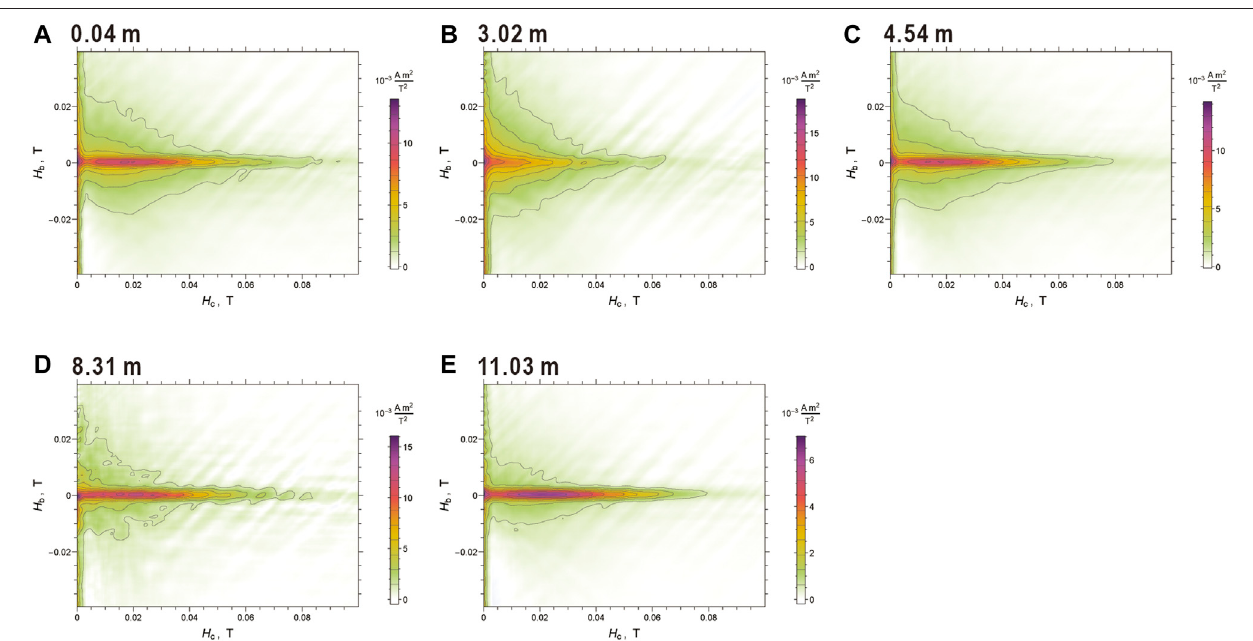
FIGURE 3 | First-order reversal curve (FORC) diagrams of fi ve samples (A – E) selected from lithologically distinct layers of core SO264-19 – 2 (dashed lines in Figure 2 top). The FORC diagrams in particular of lower core sections (D,E) show dominant central ridge maxima typical of biogenic SD magnetite (Egli et al., 2010). FORC diagrams (A,C) have a larger off-axis spread in the coercivity range of H c ≤ 40 mT representing fi ne-grained detrital magnetite. Magnetically soft, internally interacting (volcaniclastic?) MD particles are localized parallel to the H b axis. Ash layer (B) lacks a dominant central ridge maximum and instead shows a wide double-sided triangular spread below H c (cid:1) 60 mT re fl ecting interacting magnetic vortex state (VS) inclusions in a glassy matrix.